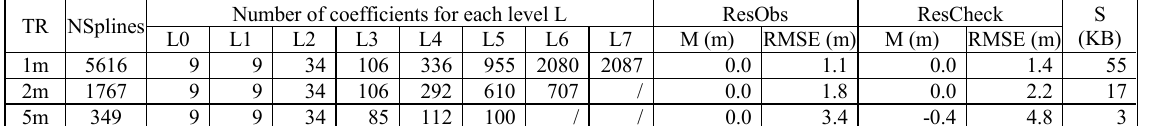
Table 4. Statistics of DTM MR . TR: interpolated dataset. NSplines: total number of activated splines. ResObs, ResCheck: statistics of the residuals on the used observations and the check points. M: mean. RMSE: root mean square error. S: storage size.